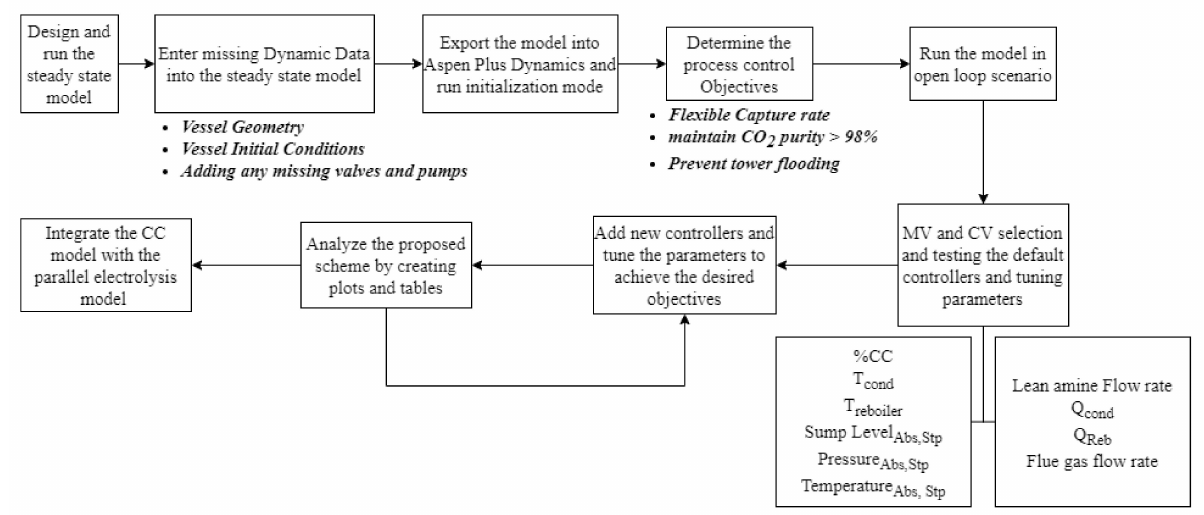
Figure 3. Exporting the steady-state model to the dynamic